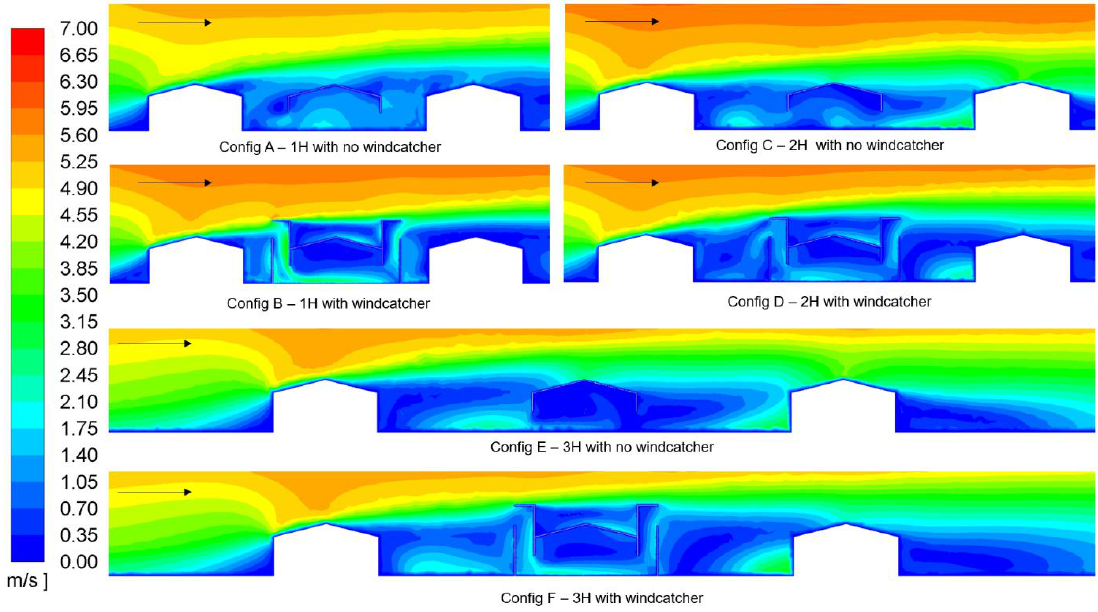
Figure 22. Velocity contours at the midplane of the greenhouse with cross-flow or windcatcher ventilation (U H = 4.4 m/s).